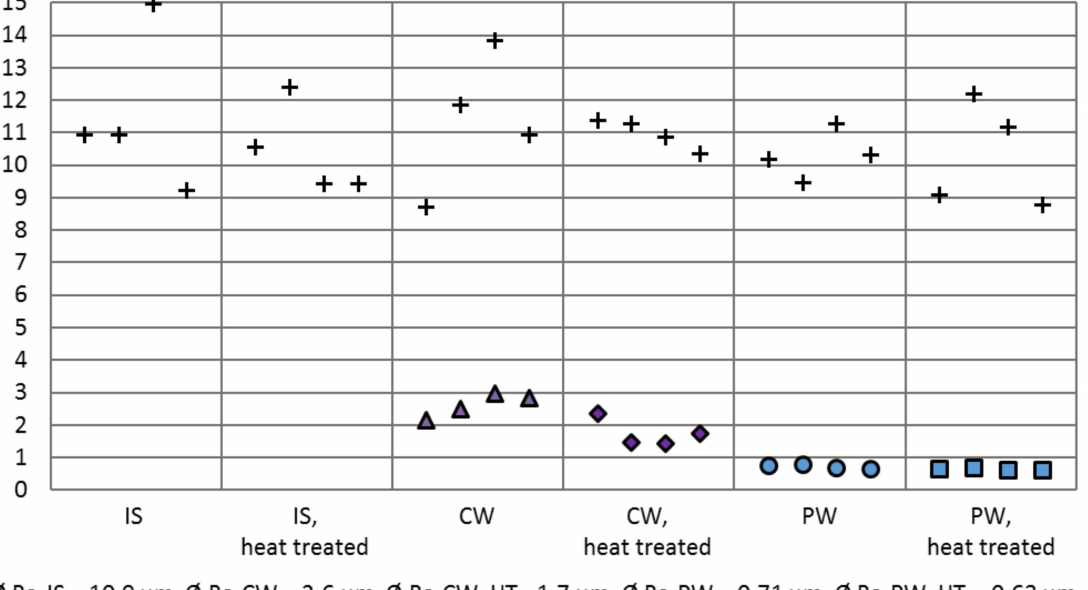
Figure 19. Initial and achieved surface roughness Ra by laser polishing of the tensile specimens, measured in fabrication